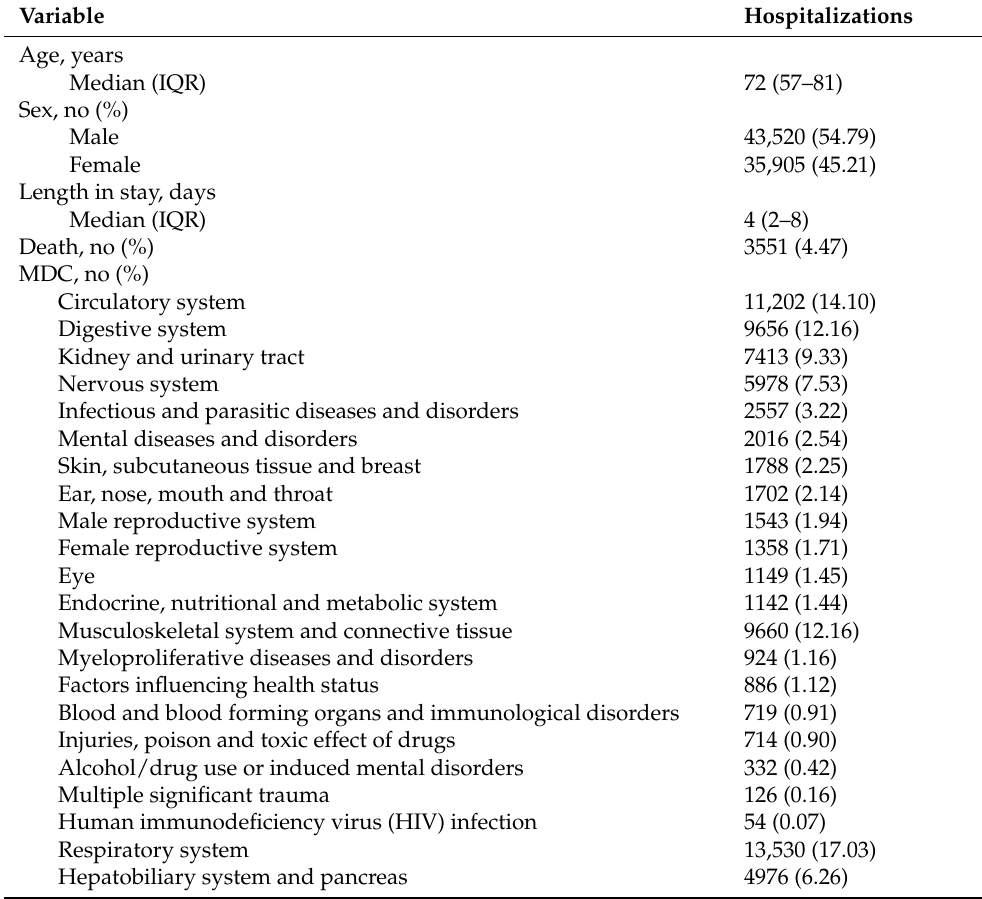
Table 1. Demographic and clinical characteristics of hospitalized adults.